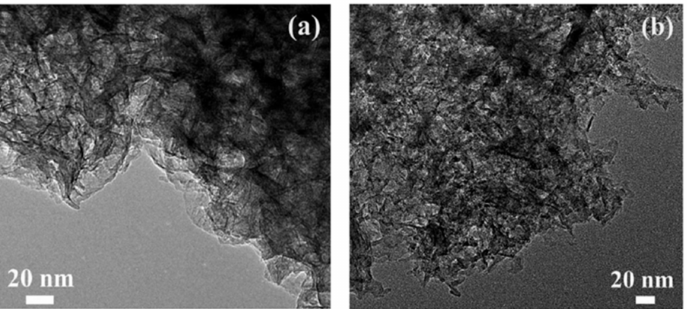
Figure 4. Transmission electron microscopy (TEM, JEM-2100F electron microscope, JEOL Ltd., Tokyo, Japan) images of ( a ) MgAl-LDH and ( b ) MgAl-MMO (adapted from [59] with permission with Royal Society of Chemistry, 2016).